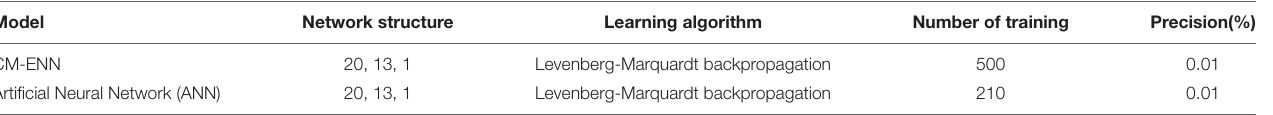
FIGURE 10 | The response curve of RMS of total acceleration a w and longitudinal acceleration a y . TABLE 5 | Comparison of results by Elman neural network and multi-layer neural